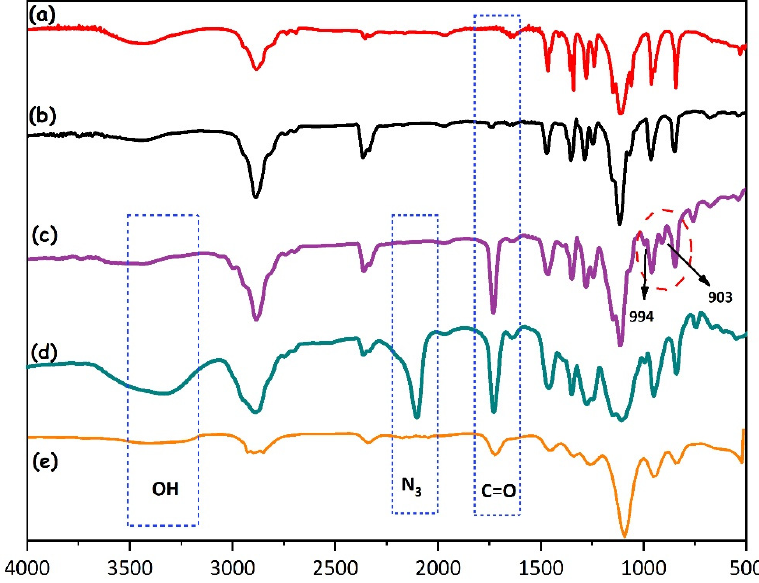
Figure 3. FTIR spectra of ( a ) PEO, ( b ) PEO ‐ Br macroinitiator, ( c ) PEO ‐ b ‐ PGMA block copolymer ( d ) PEO ‐ b ‐ PGMA ‐ N 3 , and ( e ) CCL micelles of PEO ‐ b ‐ PGMA. ( d ) PEO- b -PGMA-N 3 , and ( e ) CCL micelles of PEO- b